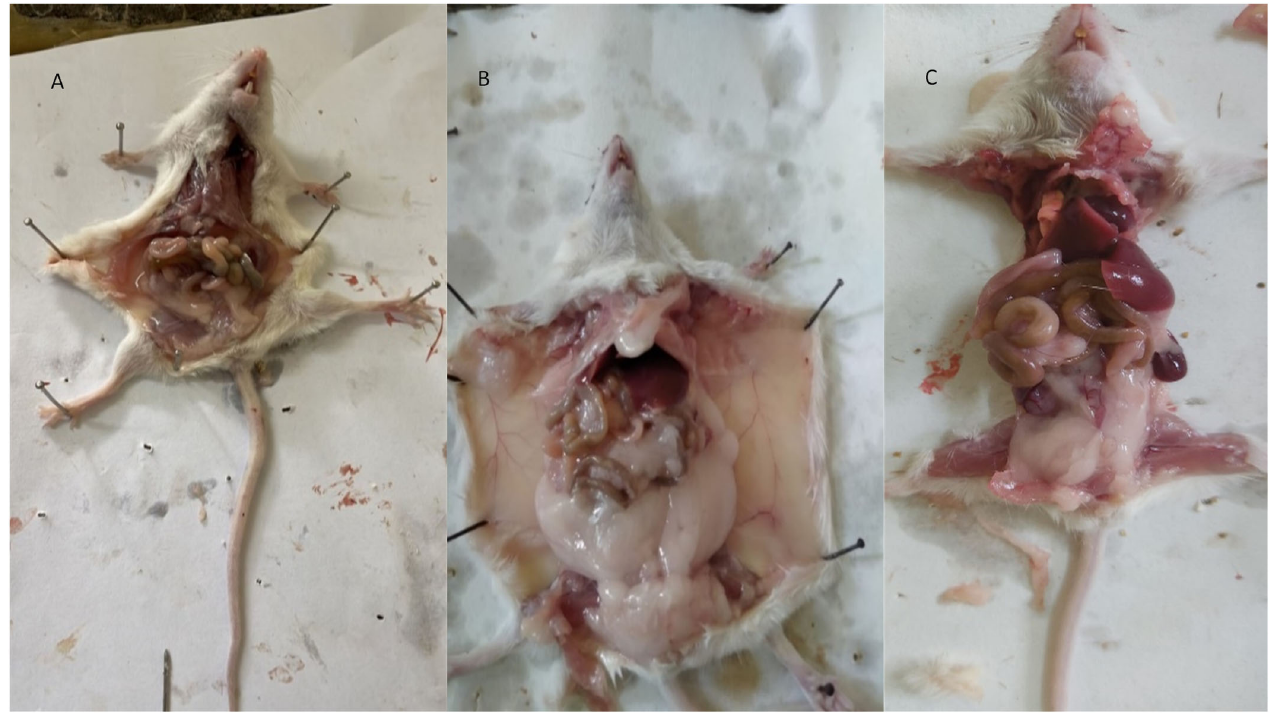
Figure 8. Comparison of visceral fat reduction in the CGA ‐ treated group to that in the PCOS ‐ in ‐ duced LETZ group. The CGA ‐ treated group had less fat tissue in the abdominal cavity, especially around the uterus and ovaries. The image in ( A ) shows visceral fat displayed in control group, while ( B ) represents LETZ and ( C ) represents LETZ with CGA.